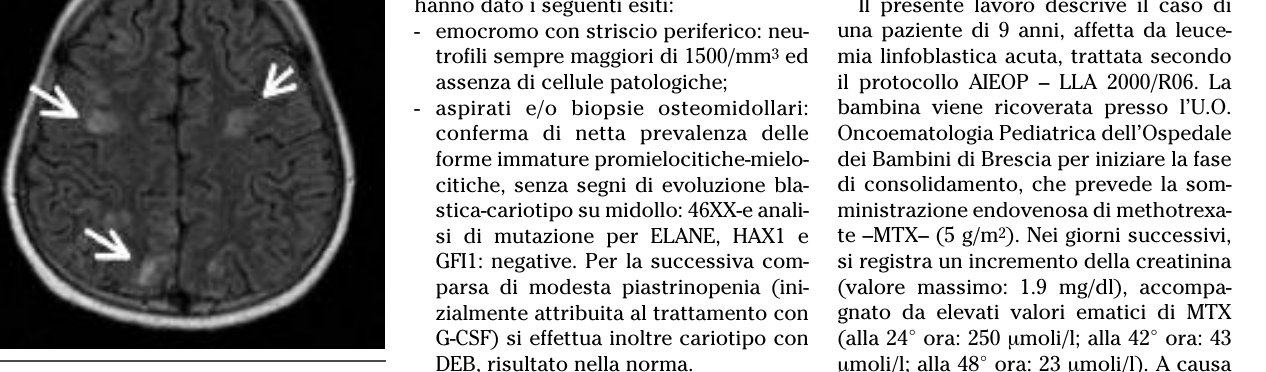
Figura 1. Lesioni su base vascolare compa- tibili con PRES alla RMN